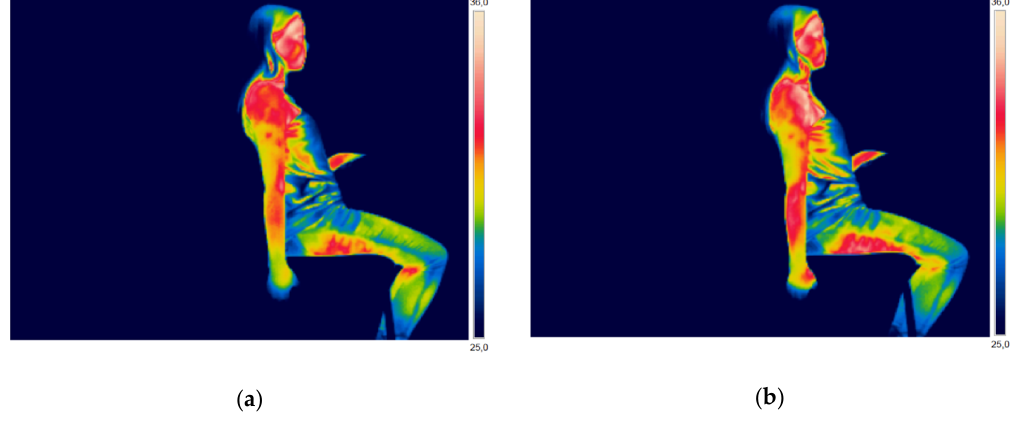
Figure 4. Thermographic image of a female participant: ( a ) before performing the high-risk repetitive task; and, ( b ) after performing the high-risk repetitive task.